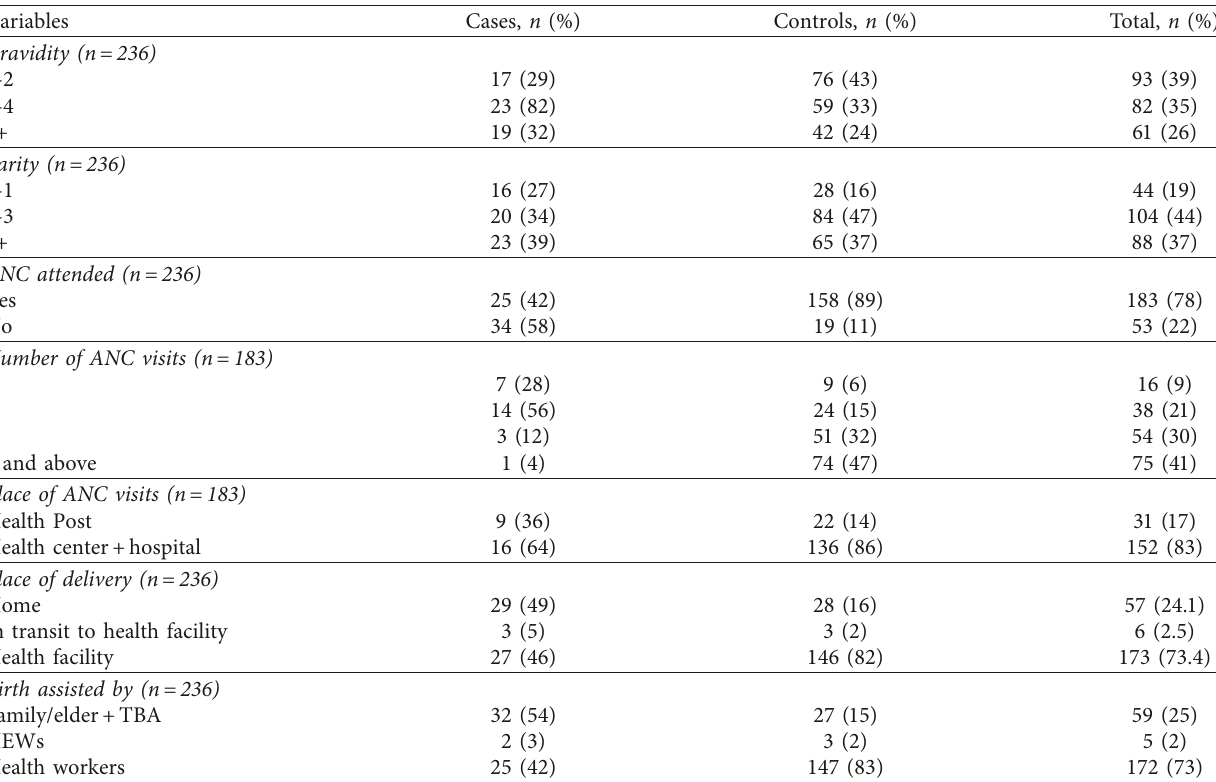
Table 3: Obstetric history of pregnant women who delivered between September 2014 and March 2017 at pastoralist area of Borena zone, Oromia region, Ethiopia.